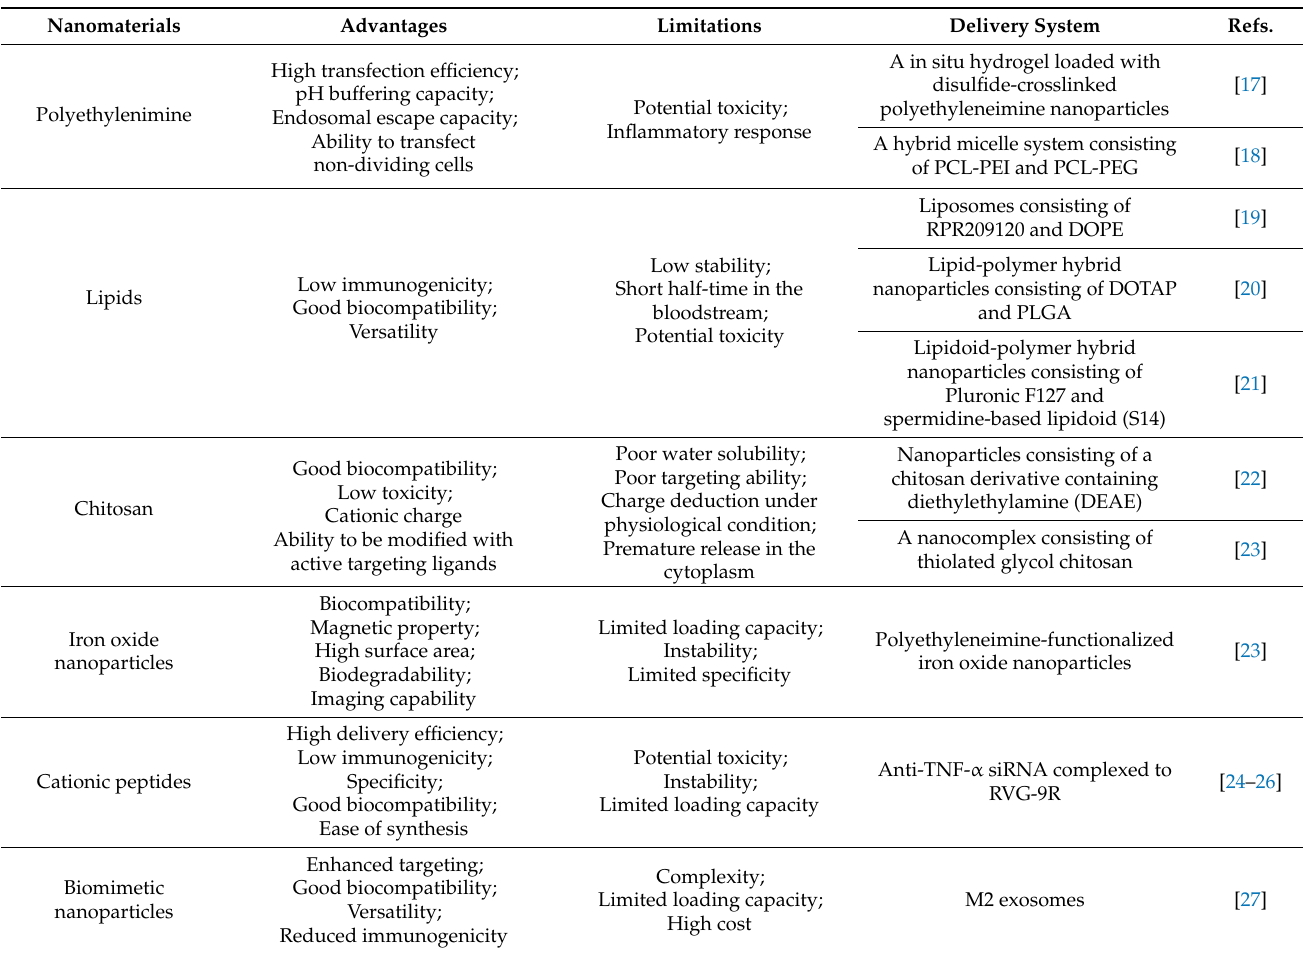
Table 1. Nanomaterials for RA gene